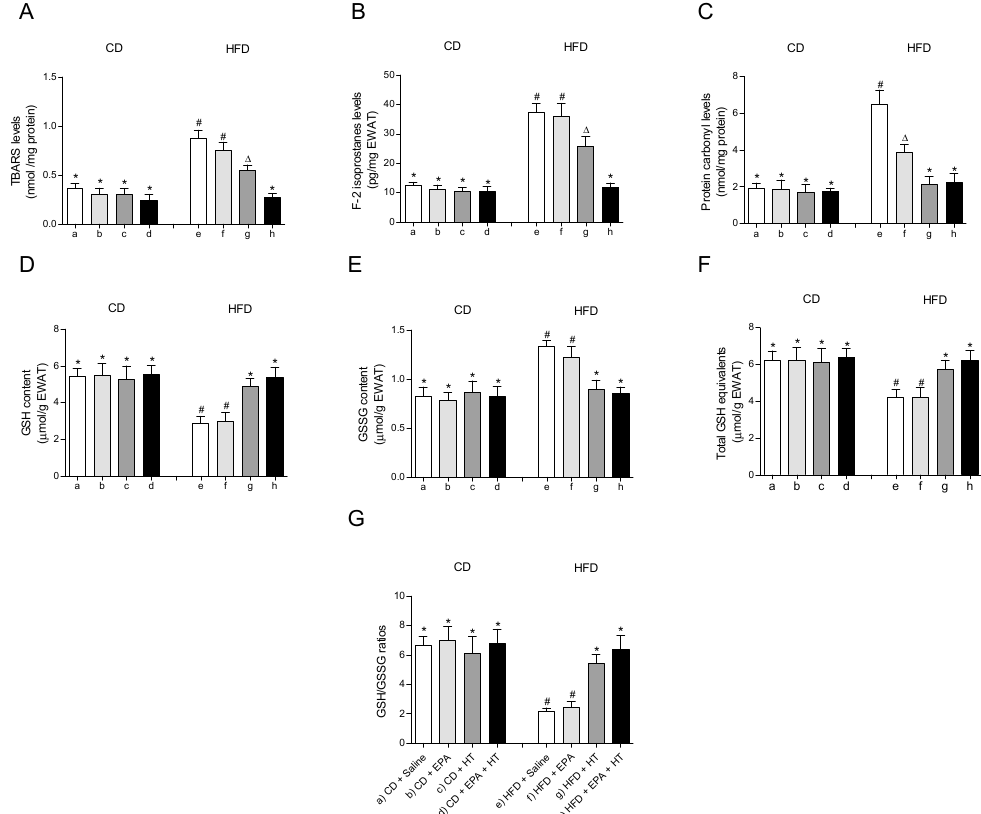
Figure 1. Thiobarbituric acid reactive substances (TBARS), ( A ) F-2 isoprostanes, ( B ) protein carbonyl groups, ( C ) reduced glutathione (GSH) content, ( D ) glutathione disulfide (GSSG) levels, ( E ) total GSH equivalents (GSH + 2GSSG) and ( F ) GSH/GSSG ratio ( G ) in epididymal white adipose tissue from mice subjected to control diet (CD) and high-fat diet (HFD) supplemented or not with eicosapentaenoic acid (EPA), hydroxytyrosol (HT) or EPA + HT. Values are expressed as mean ± SD. Eight to ten mice were included in each experimental group. Groups that do not share the same superscript symbol were significantly different among them, namely, (a), CD + saline; (b) CD + EPA; (c) CD + HT; (d) CD + EPA + HT; (e), HFD + saline; (f) HFD + EPA, (g) HFD + HT; and (h), HFD + EPA + HT, according to two-way analysis of variance (ANOVA) followed by the Tukey’s post-test, p < 0.05. ( * ), does not differ from (a) group; ( # ), differ from (a) group; ( ∆ ), differ from (a) and (b) groups.